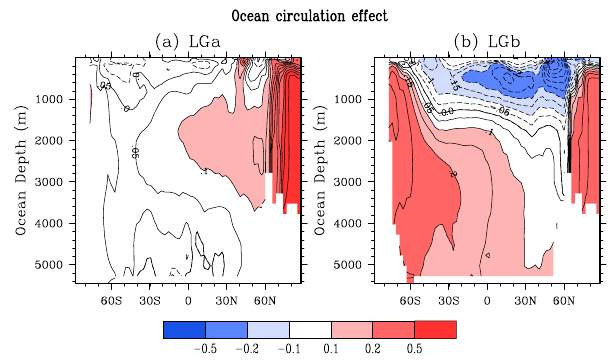
Fig. 12. Global zonal-mean preformed phosphate anomalies (µmolkg − 1 ) due to ocean circulation change (a) between LGa and LGa-oc and (b) between LGb and